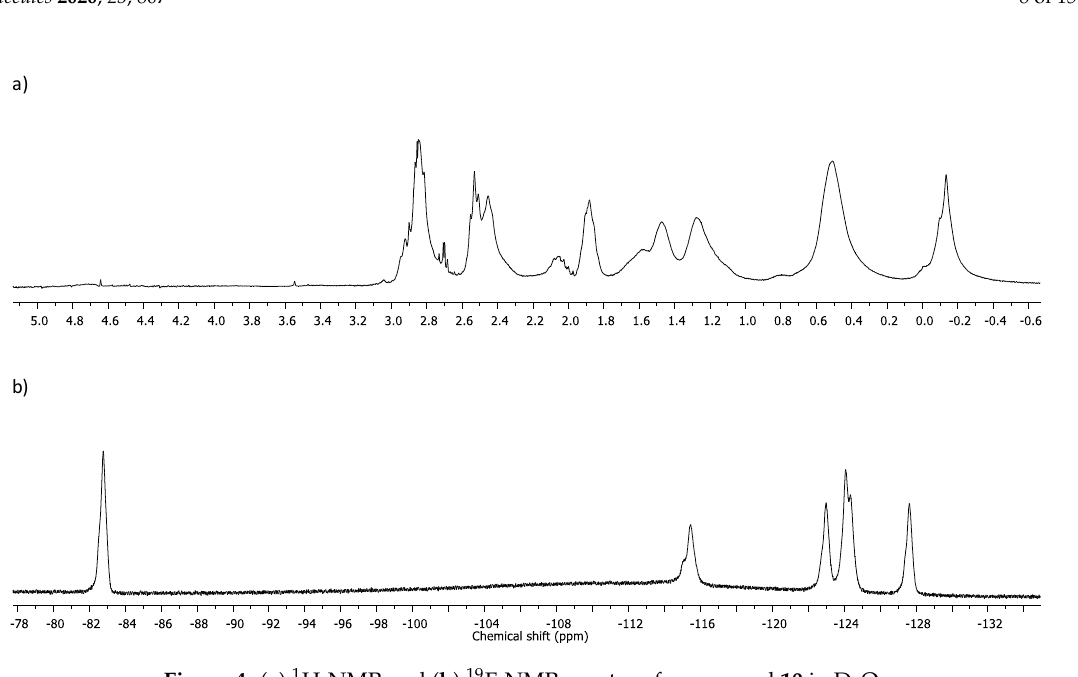
Figure 4. ( a ) 1 H-NMR and ( b ) 19 F-NMR spectra of compound 10 in D 2 O.